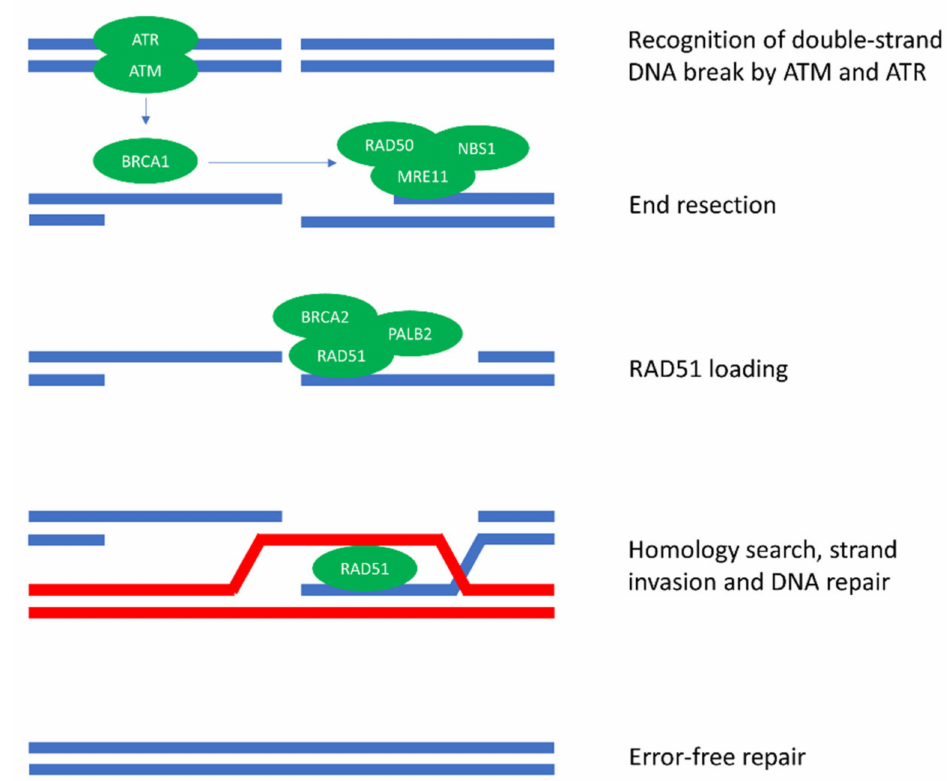
Figure 1. Homologous recombination repair (HR). HR commences with the recognition of double- strand DNA breaks by ATM and ATR. ATM and ATR activate BRCA1, which plays a key role in the recruitment of repair proteins needed for DNA end resection. DNA end resection generates a long 3 (cid:48) single-strand DNA tail that can invade the homologous DNA strand (sister chromatid) . After end resection, RAD51 is loaded on the single-strand DNA tail with the help of BRCA2 and PALB2. The strand then invades the homologous DNA strand where the actual DNA repair is performed. Since a sister chromatid is used as a template for DNA repair, HR is considered a relatively error-free process. Of note, besides the proteins depicted here, many other proteins are involved in